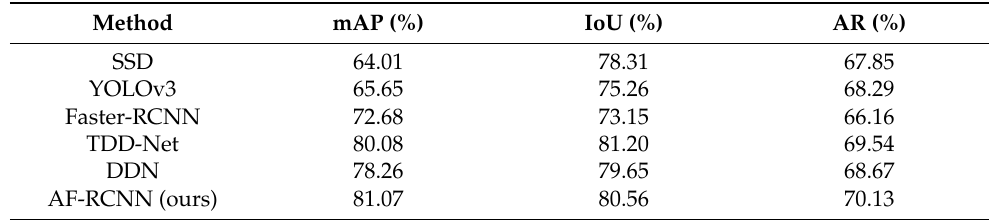
Table 1. Detection results of each detection